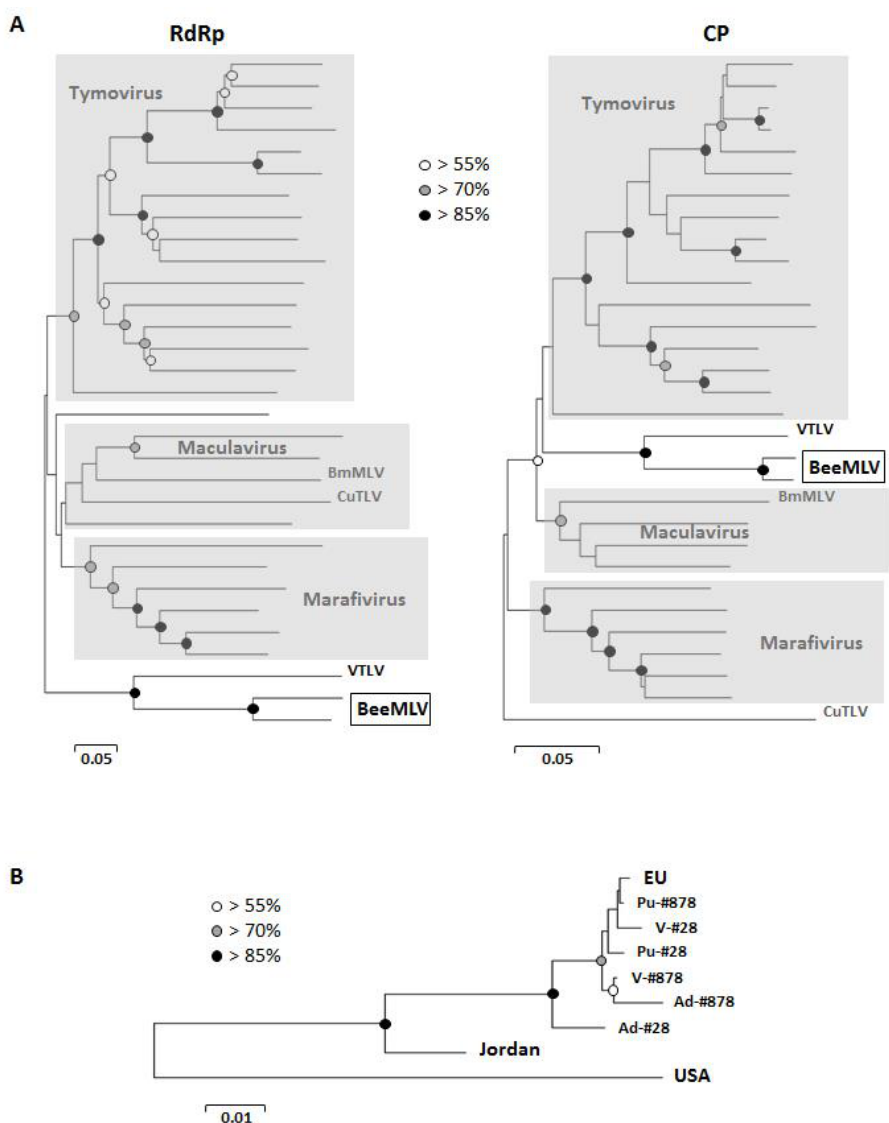
Figure 2. ( A ) Unrooted Minimum Evolution phylograms describing the relationship between BeeMLV and other viruses in the Tymoviridae, based on the RNA-dependent RNA polymerase and capsid protein amino acid sequences. The scale bar represents the inferred evolutionary distance in amino acid substitutions per site. Bootstrap support for the various nodes is indicated by the white (>55%), grey (>70%) and black (>85%) circles. The Tymovirus, Marafivirus and Maculavirus genera are marked with grey-shaded areas. The two insect-infecting Tymoviridae ; Bombyx mori Macula-like latent virus (BmMLV) and Culex Tymoviridae-like virus (CuTLV) are indicated in both phylograms, as well as a second Tymoviridae-like virus (VTLV) recovered in these studies; ( B ) Unrooted Minimum Evolution phylogram describing the relationship between different geographic and biological BeeMLV isolates, based on the capsid protein nucleotide sequence. The scale bar represents the inferred evolutionary distance in nucleotide substitutions per site. Bootstrap support is indicated as for Figure 2A. The taxa are consensus nucleotide sequences from Europe, Jordan, the USA and the pupal (Pu), adult (Ad) and varroa (V) pooled samples from apiaries in northern France (#28) and southern France (#878).